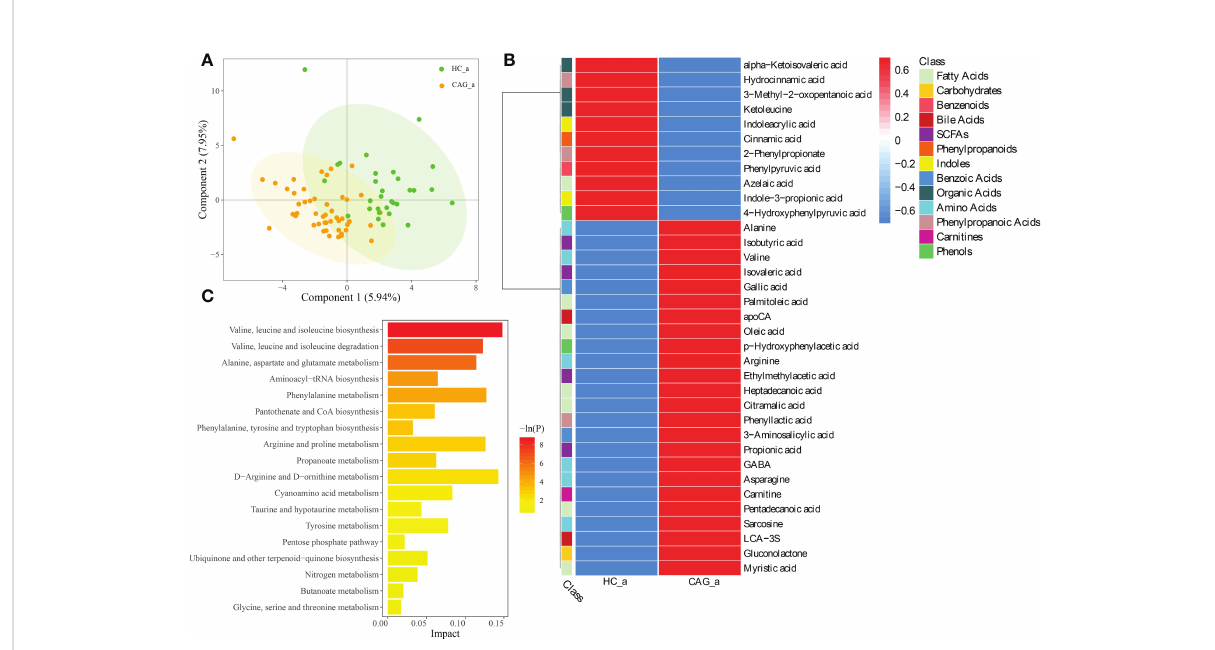
FIGURE 2 Alteration of fecal-derived metabolites pro fi les in CAG_a patients. (A) PLS-DA indicated the difference of fecal metabolites between CAG_a and HC_a healthy volunteers. (B) Alteration of fecal-derived metabolites pro fi les in CAG_a patients. (C) All differential metabolites enriched for metabolic pathways based on KEGG analysis. Values were expressed as mean ± SD (n=30/HC_a, n=48/CAG_a) Data were analyzed by t-test or Wilcoxon test based on whether the data were normally distributed between CAG_a group and HC_a